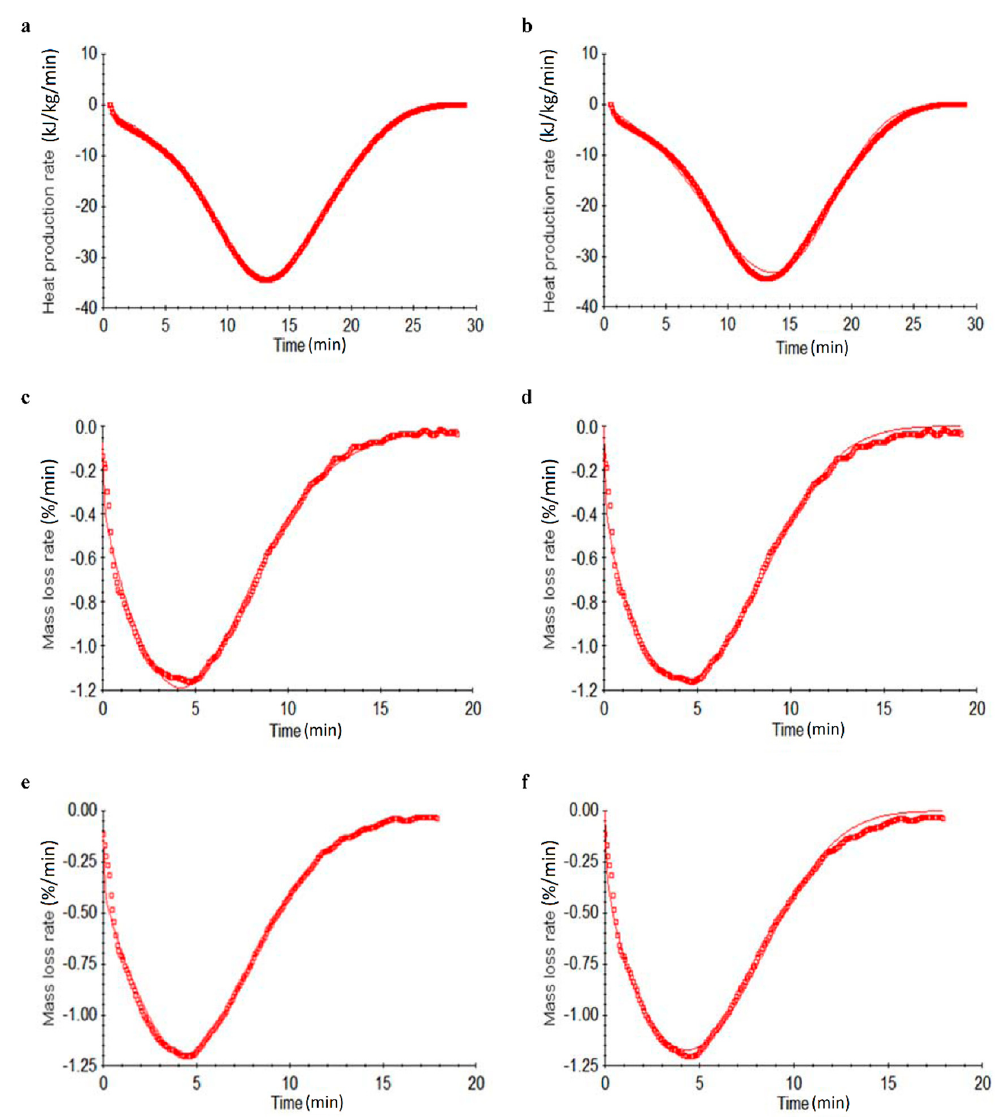
Figure 6. Adsorption kinetics of differential scanning calorimetry (DSC) ( a and b ) and differential thermogravimetric (DTG) ( c and d under a nitrogen atmosphere; e and f under an air atmosphere) curves by comparing proto-kinetic ( a , c , and e ) and Erofeev’s ( b , d , and e ) equation simulation analyses at the selected heating rate of 6 °C/min (hollow block is experimental data and — line is simulation results) (here, only the heating rate of 6 °C/min analysis is presented, but the complete analysis results also involved the various heating/scanning rates of 8 and 10 °C/min, and then compared all the results).